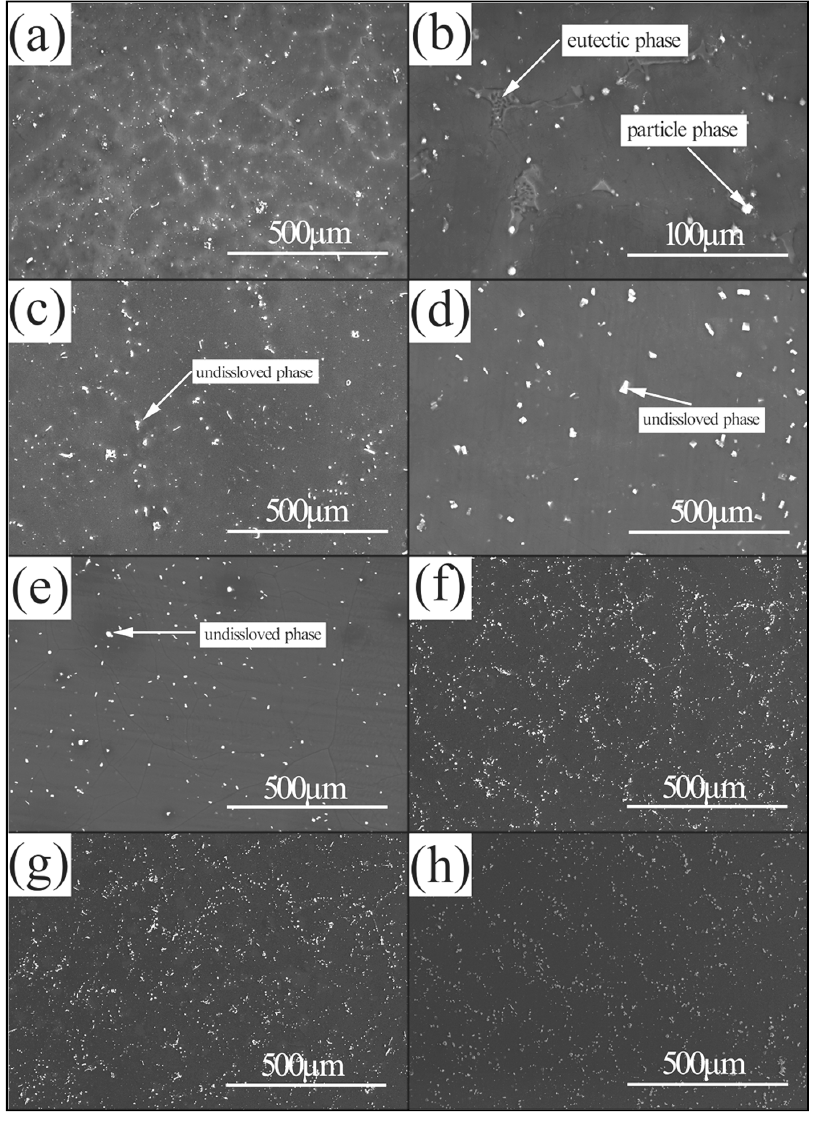
Figure 3. The scanning electron microscopy (SEM) of different samples: ( a ) As-cast; ( b ) closed-up view of ( a ); ( c ) T4-air quenching; ( d ) T4-water quenching; ( e ) T4-cryogenic quenching; ( f ) T6-air quenching; ( g ) T6-water quenching and ( h ) T6-cryogenic quenching.